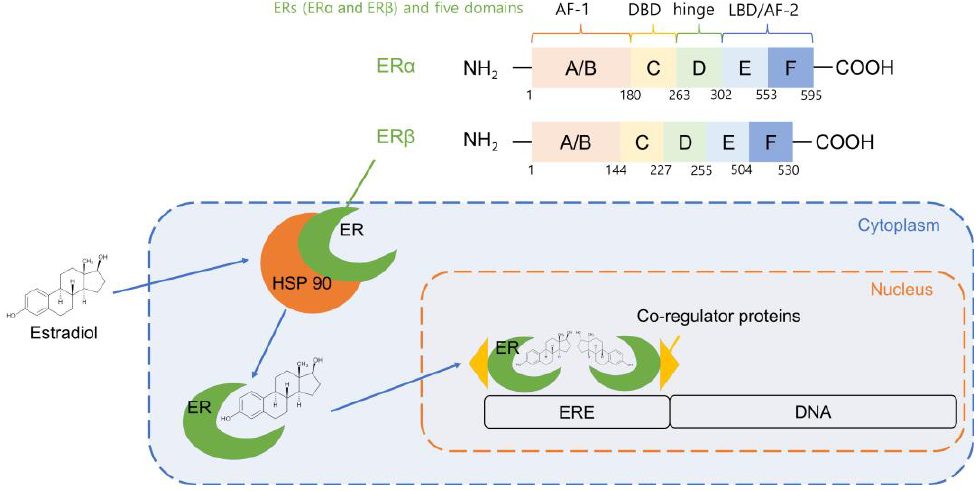
Figure 2. Estrogen receptors (ERs) and estrogen response elements (EREs).